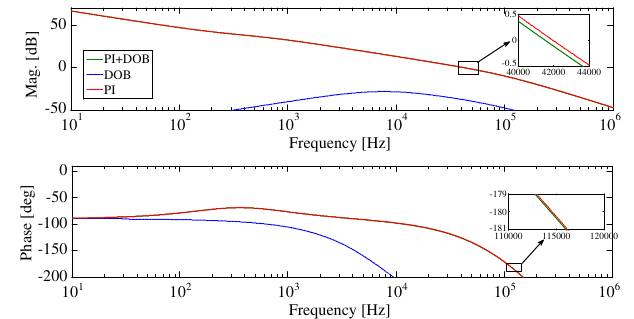
. The magnitude T n < 0 dB is T n